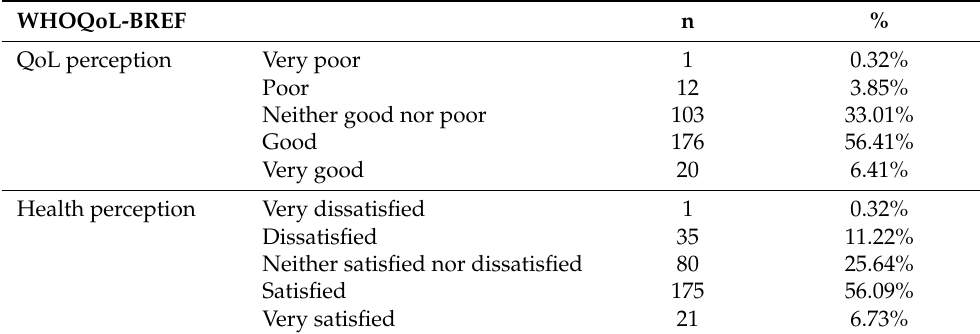
Table 4. The scores obtained from the WHOQoL-BREF questionnaire, measuring QoL perception and health perception.